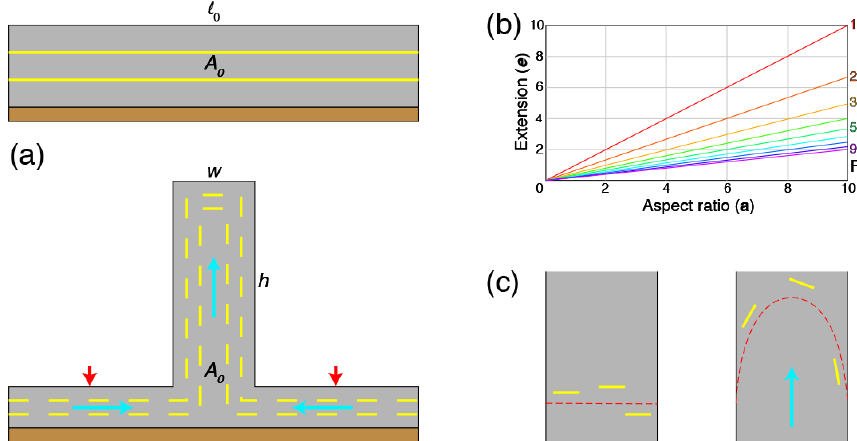
Figure 13. Conceptual diagrams of passive diapirism emphasizing the intrasalt strong layers and ignoring complex halite-dominated folding: (a) salt layer of area A 0 and with two strong layers (yellow) of length l 0 (top) is the source for salt flowing into the diapir with width w and height h (bottom) in a plane-strain, constant-area scenario – flow into and up the diapir (blue arrows) results in lengthening and boudinage of strong layers; (b) graph showing extension e of strong layers as a function of the aspect ratio a and the fetch factor F (see text); (c) Poiseuille flow up diapir, as shown by deflection of imaginary horizontal line (red, left) to its deformed equivalent (right) results in shear-induced rotation of stringers (yellow) to near-vertical orientations in most cases.